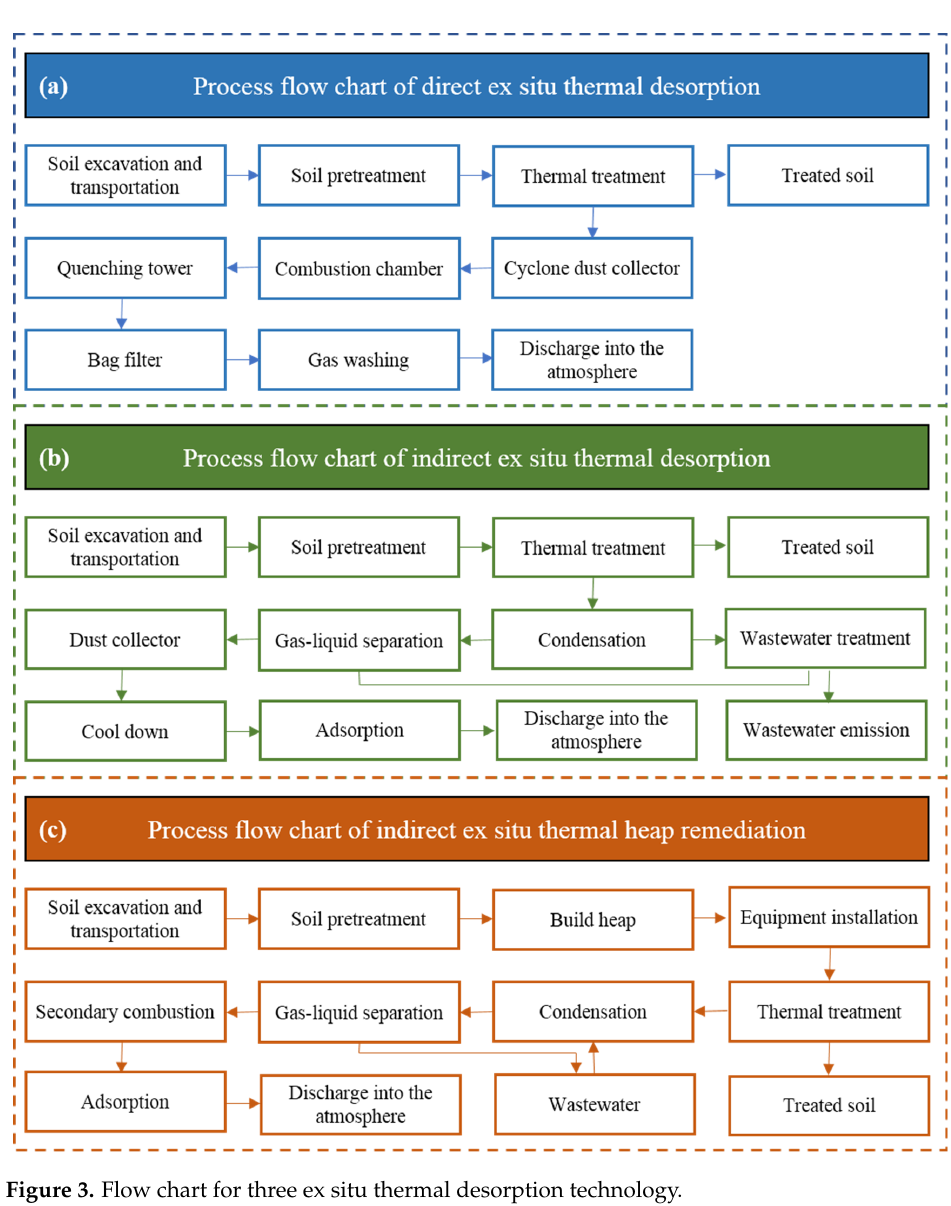
Figure 3. Flow chart for three ex situ thermal desorption